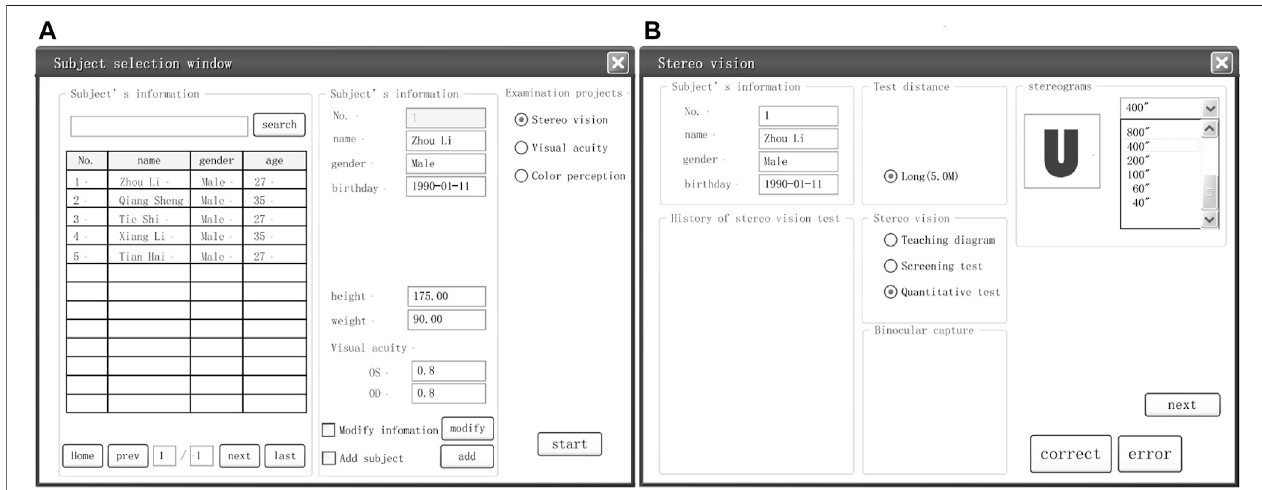
FIGURE 4 | An example of interfaces designed for the GFDRDSS. (A) General information registration and inspection item selection interface. (B) Stereovision examination interface.